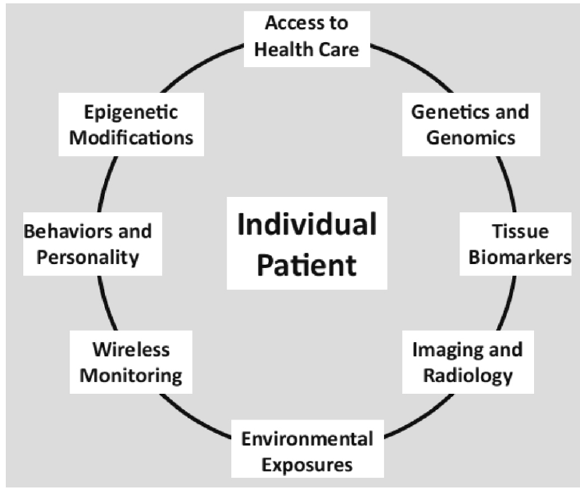
Figure 2. Different components that permeate individualized/ centralized patient care currently. [7]